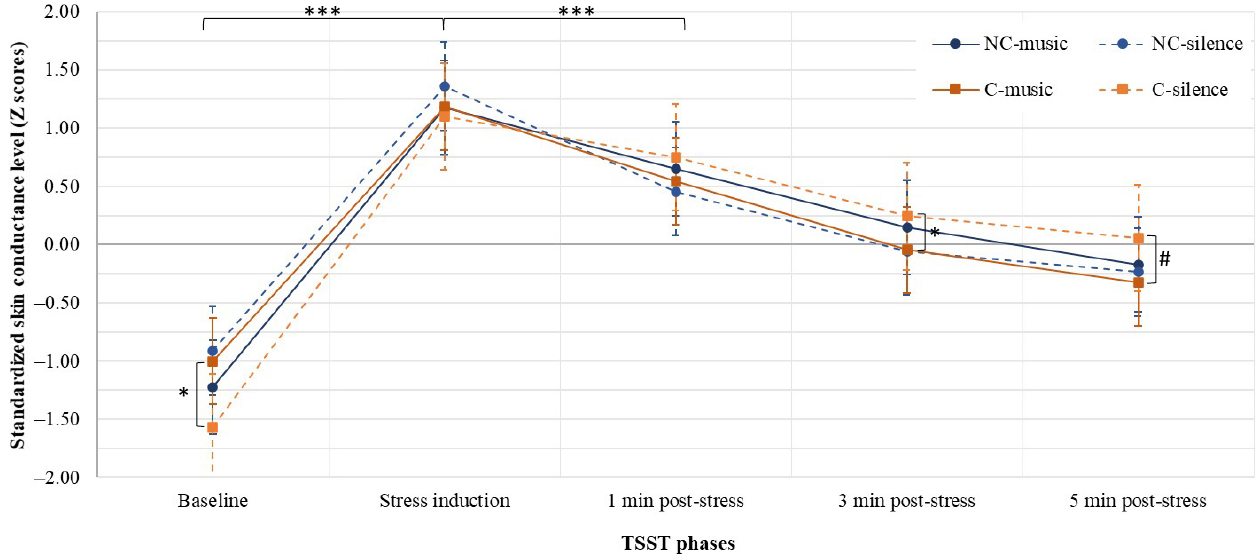
Figure 3. Standardized SCL extracted at each time point during the TSST procedure, presented as a function of group (mean ± standard error of the mean). *** p ≤ 0.001. * p ≤ 0.05. # p = 0.059.